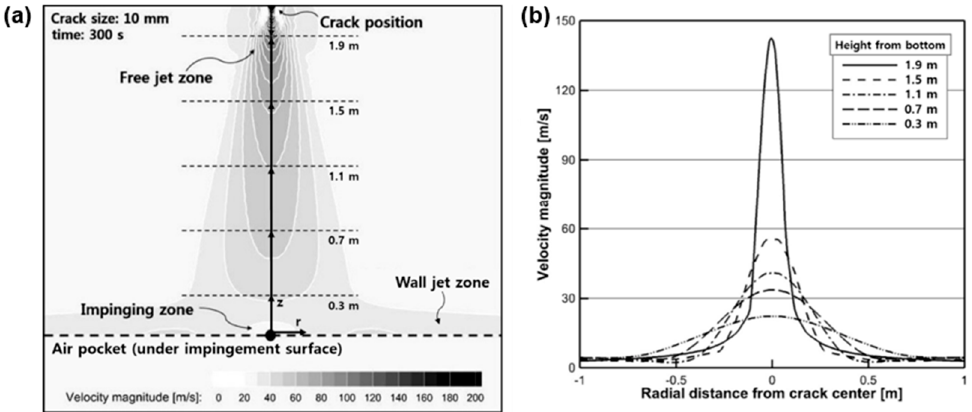
Figure 4. ( a ) Velocity field from crack to bottom surface, and ( b ) velocity profile in radial direction with respect to height from bottom in the case of 10 mm crack size at 300 s.